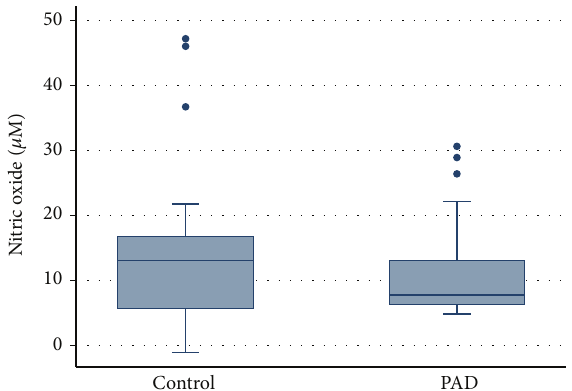
Figure 3: Plot of distribution of NO concentrations for age and gender matched controls and patients with PAD, 𝑝 = 0.662